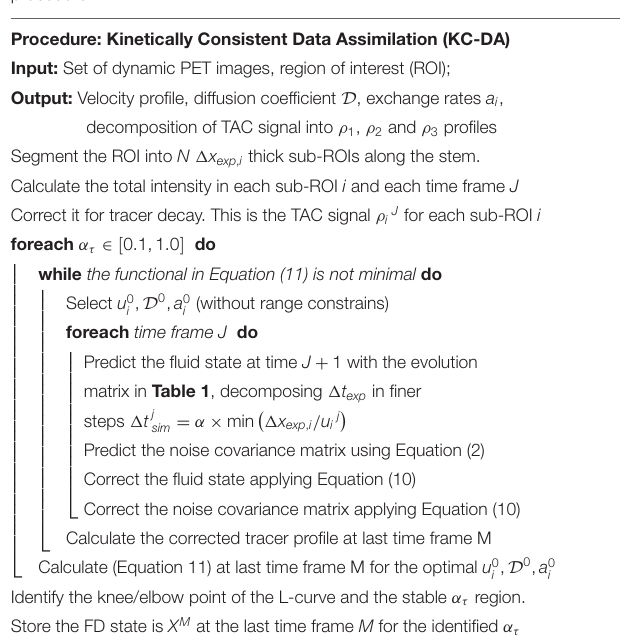
Predict the noise covariance matrix using Equation (2) Correct the fluid state applying Equation (10) Correct the noise covariance matrix applying Equation (10) Calculate the corrected tracer profile at last time frame M Calculate (Equation 11) at last time frame M for the optimal u 0 i , D 0 , a 0 i Identify the knee/elbow point of the L-curve and the stable α τ